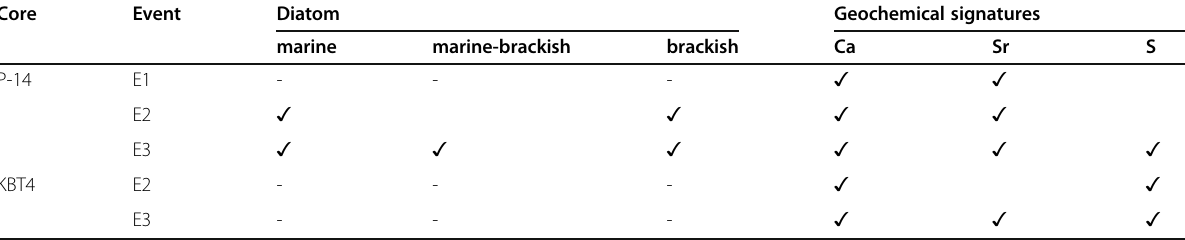
Table 3 Proxy check list of event sand layers in the cores (P-14 and KBT4)